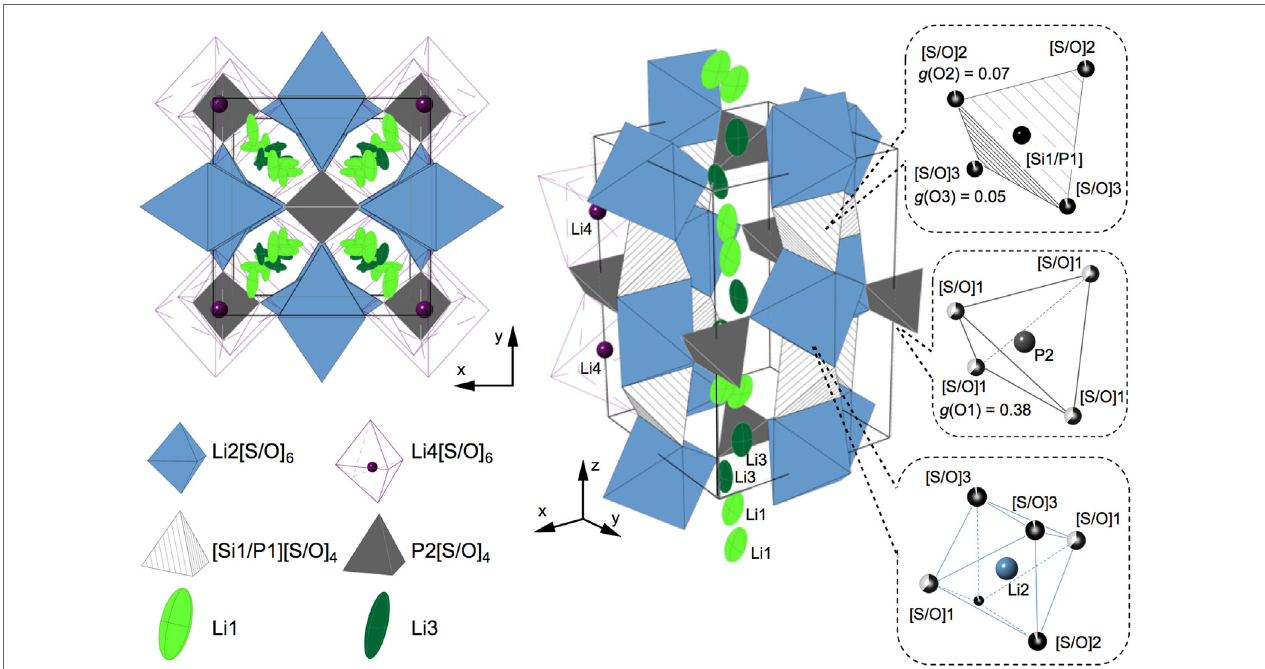
FigUre 6 | schematic drawings of the lsiPsO crystal structure determined by rietveld analysis . The structure is represented by polyhedrons and ellipsoids; the blue and purple octahedra represent Li2(4 d )[S/O] 6 and Li4(4 c )[S/O] 6 , respectively; the hatched and dark gray tetrahedra represent [Si1/P1][S/O] 4 and P2[S/O] 4 , respectively; Li1(16 h ) and Li3(16 h ), which show large atomic displacement parameters, are drawn with a 50% probability as light- and dark-green ellipsoids, respectively. Li1 and Li3 are distributed along the c -axis in the framework composed of Li2[S/O] 6 octahedra, [Si1/P1][S/O] 4 tetrahedra, and P2[S/O] 4 tetrahedra. The left side shows the top view from the c -direction. The right side shows a perspective view, in which parts of Li1, Li3, and Li4 are not drawn for simplicity. The coordination of the sulfide/oxide atoms in the polyhedral is indicated in the dotted rectangles along with the occupation parameters, g , for the oxide